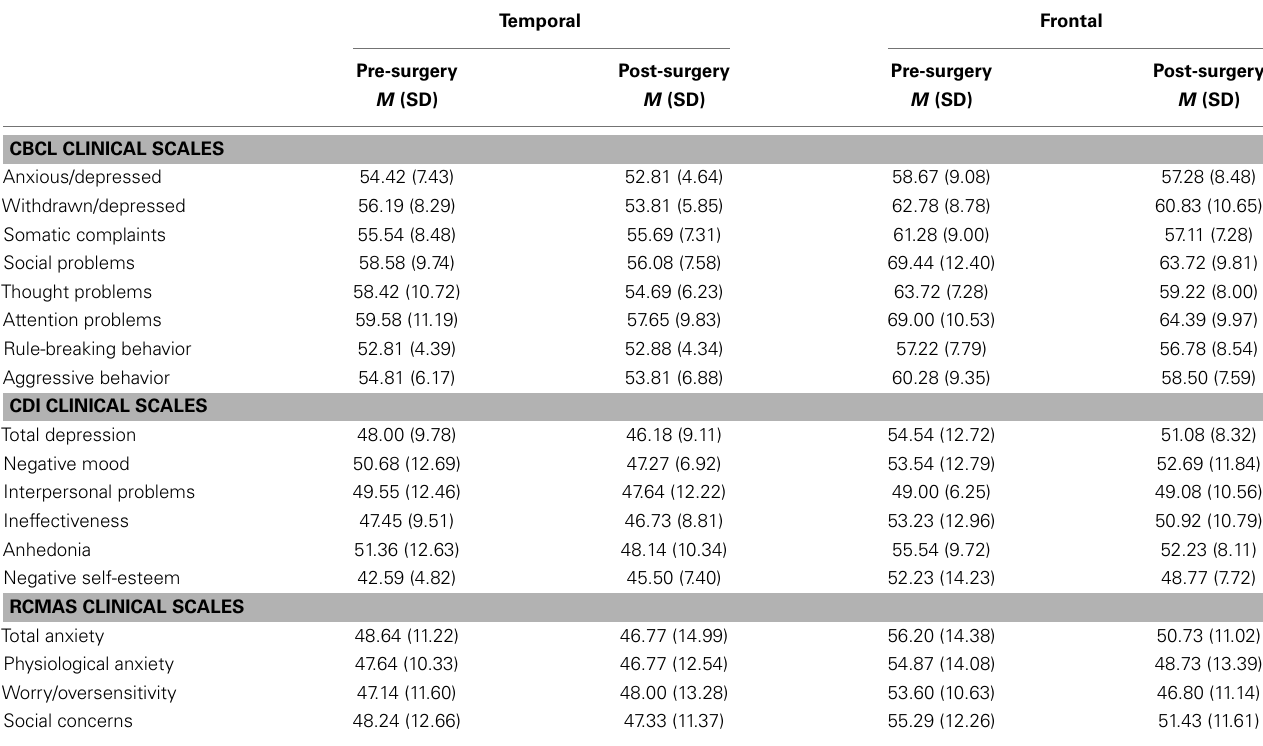
Table 3 | Mean scores on mood, anxiety, and behavior measures for patients who underwent right-sided surgeries . Temporal